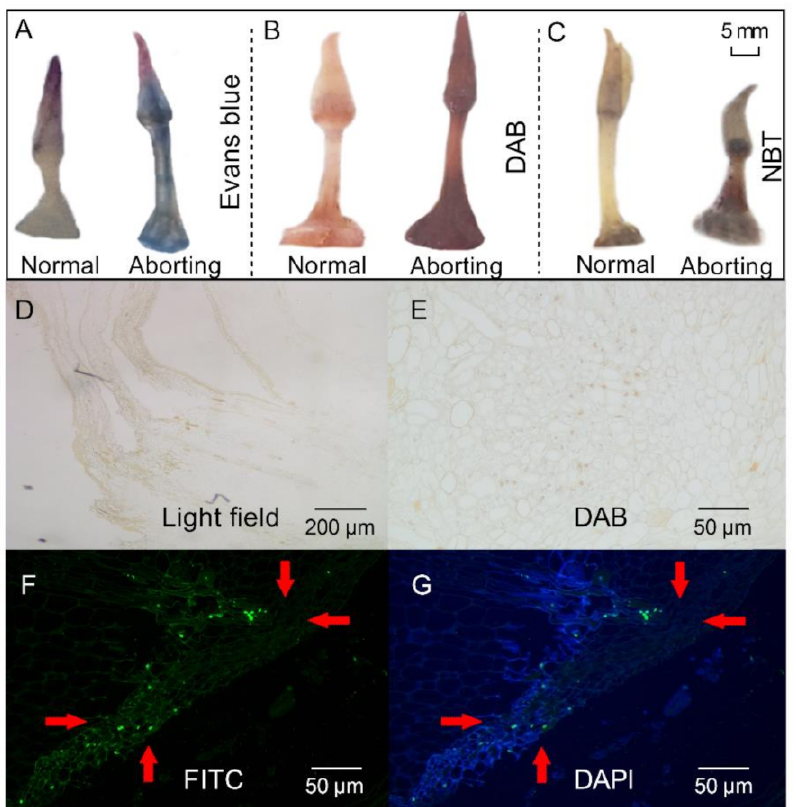
Figure 2. Histochemical staining and TdT-mediated dUTP-biotin nick end labeling (TUNEL) staining of lotus flower buds. After growing for 2 months, 2- to 3-cm-long flower buds were excised for different staining. ( A – C ) Evans blue ( A ), 3, 3-diaminobenzidine (DAB) ( B ), and nitro blue tetrazolium chloride (NBT; ( C )), staining of the normal and aborting flower buds. Bar, 5 mm; ( D ) Bright field view. ( E – G ) TUNEL analysis of the aborting flower buds stained with DAB ( E ), fluorescein isothiocyanate (FITC; ( F )), and 6-diamidino-2-phenylindole (DAPI; ( G )). The red arrows with the same direction point to the same position on the bud.